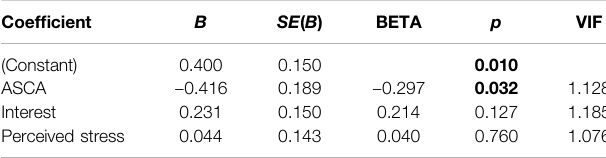
TABLE11| LinearregressionanalysiswithvariablesASCA,interestandperceived stress as predictor variables for heart rate (for the total sample). Coef fi cient